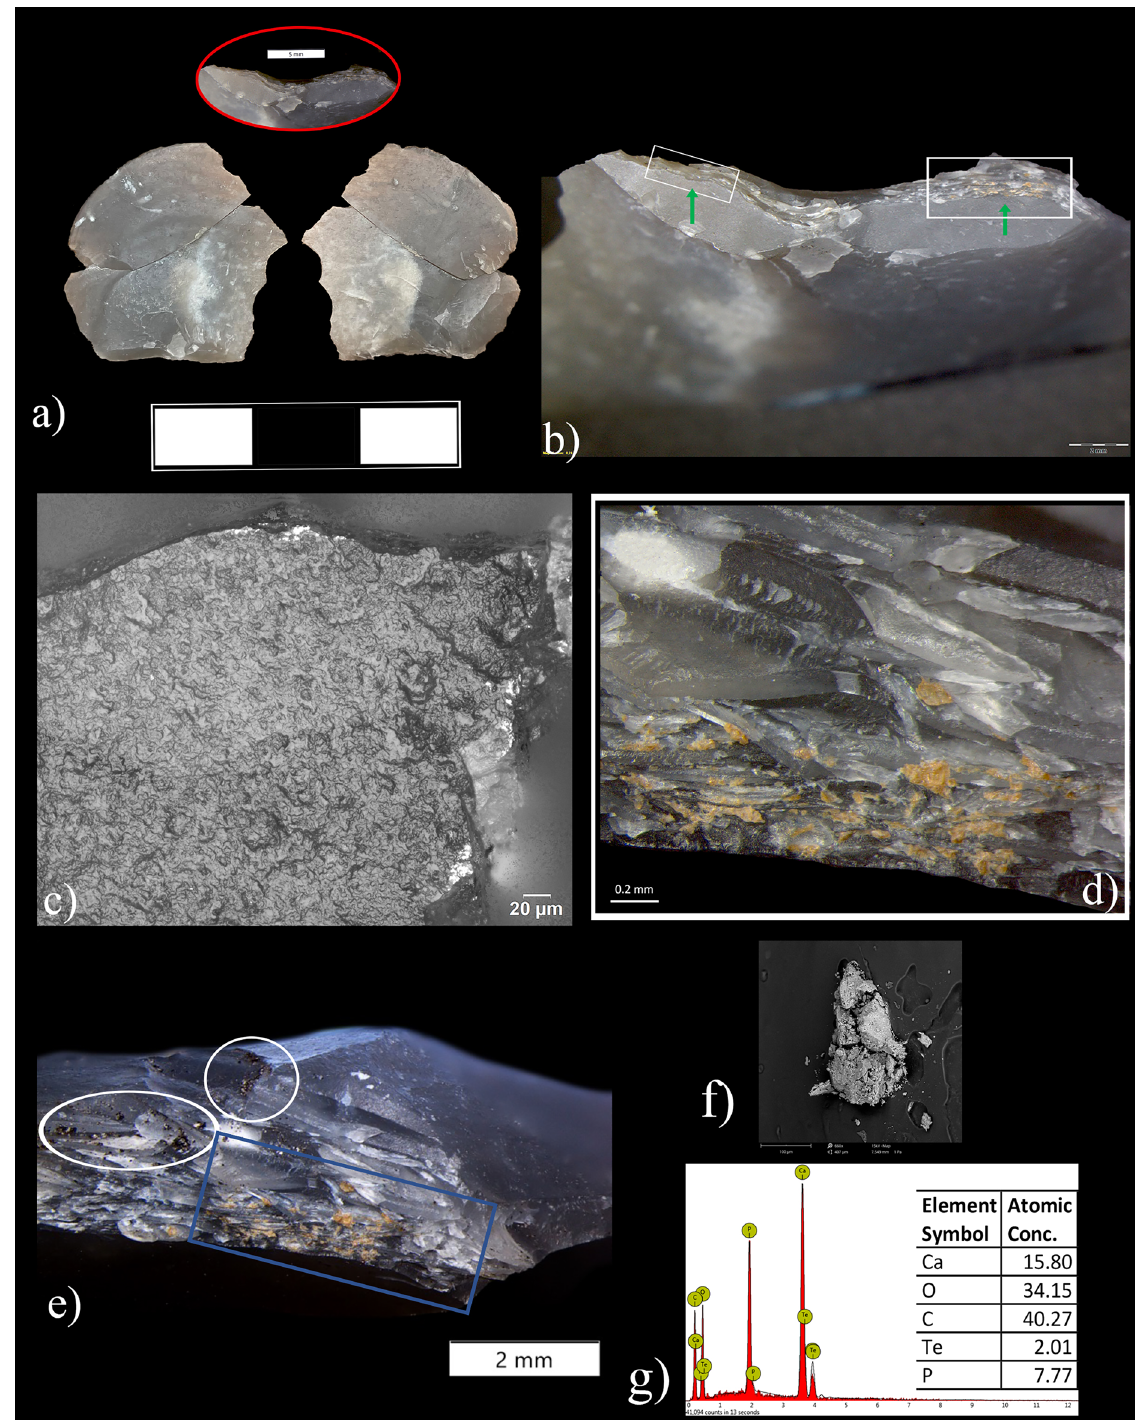
Figure 5. Archeological resharpening flake from the elephant area at the site Schöningen 13 II-3. ( a ) conjoin between ID 30251 and ID 29675; ( b ) butt of the small flake ID 30251 showing the external platform edge (green arrows) and the location of residues (white rectangles, Magnification 8x); ( c ) weak developped polish interpreted as not sufficiently diagnostic (Magnification: 500x); ( d ) micro use-related residues interpreted as tiny woody remains (Magnification: 500x); ( e ) dorsal retouch scars of small flake ID 30251 before cleaning (Magnification: 200x). Notice the clear difference between the use-related residues (blue square) and the micro blackish sediment particles (white circles), ( f,g ) extracted residue imaged using SEM and related elemental